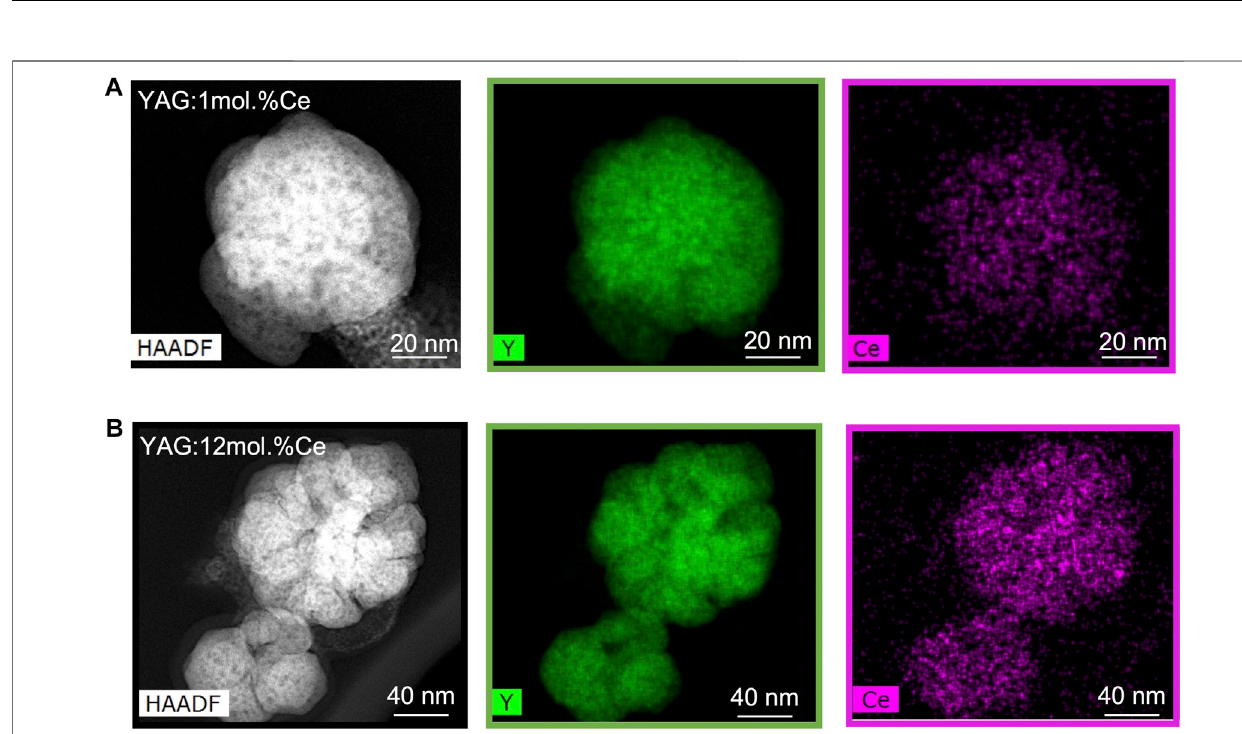
FIGURE 2 | HAADF-STEM images of YAG:1mol.%Ce (A) and YAG:12mol.%Ce (B) and the associated EDX map for Y and Ce.